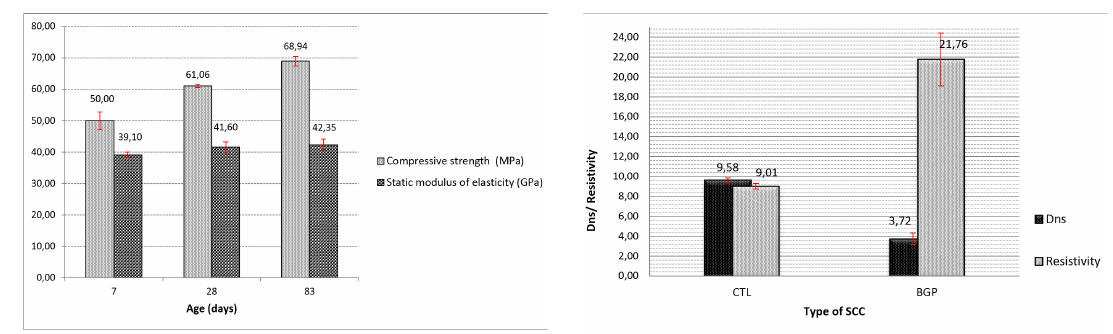
Figure 7. Results of compressive strength and modulus of elasticity for CTL SCC.